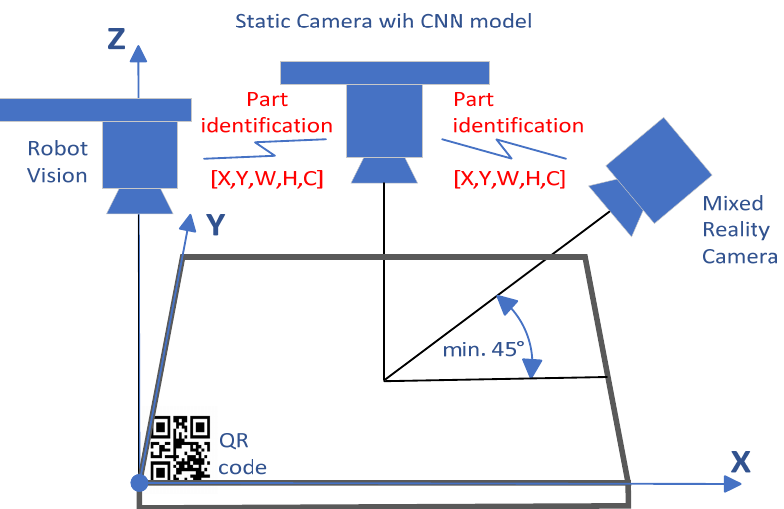
Figure 18. The principle of vision systems synchronization to one Cartesian coordinate.